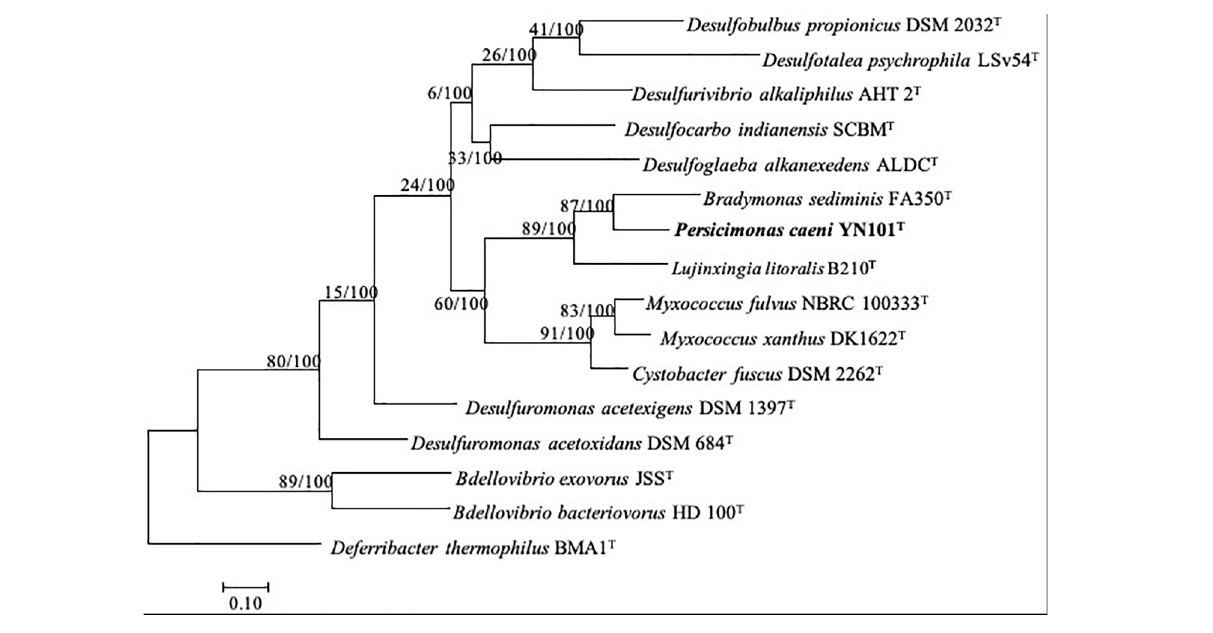
FIGURE 3 | Phylogenomic tree based on up-to-date bacterial core gene sequences of strain YN101 T and type strains of related genera within the phylum Proteobacteria . The tree was constructed using maximum-likelihood algorithm. Gene support indices (GSIs) and percentage bootstrap values are given at branching points. Bar, 0.10 substitutions per nucleotide